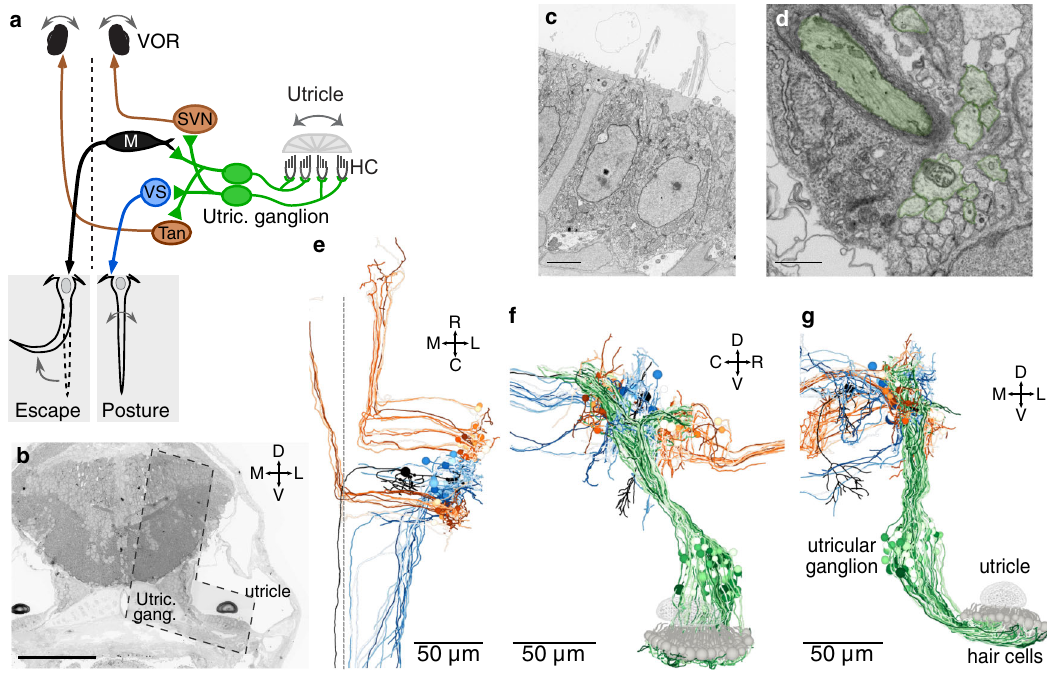
Fig. 1 | High-resolution serial-section electron microscopy of the gravity- sensingsystem.a Schematicofthe gravity-sensingsystem in fi sh.Haircells inthe utricular macula (HC, gray) are inertial sensors of head tilt and translation, exciting the peripheral process of utricular afferents (green). These afferents, whose cell bodies are located in the utricular ganglion, project to brainstem neurons involved in escape (Mauthner cell, black), posture (vestibulospinal [VS] cell, blue), and oculomotor (VOR) re fl exes (superior vestibular nucleus [SVN] and tangentialnucleus[Tan],brown).Dashedlineindicatesmidline. b Coronalsection through the head of a 5.5dpf zebra fi sh. The region reimaged at high resolution is visibleasanL-shapedterritory(dashedoutline)coveringtherightutricleandhair cells, utricular ganglion, and ipsilateral brainstem. The reimaged territory